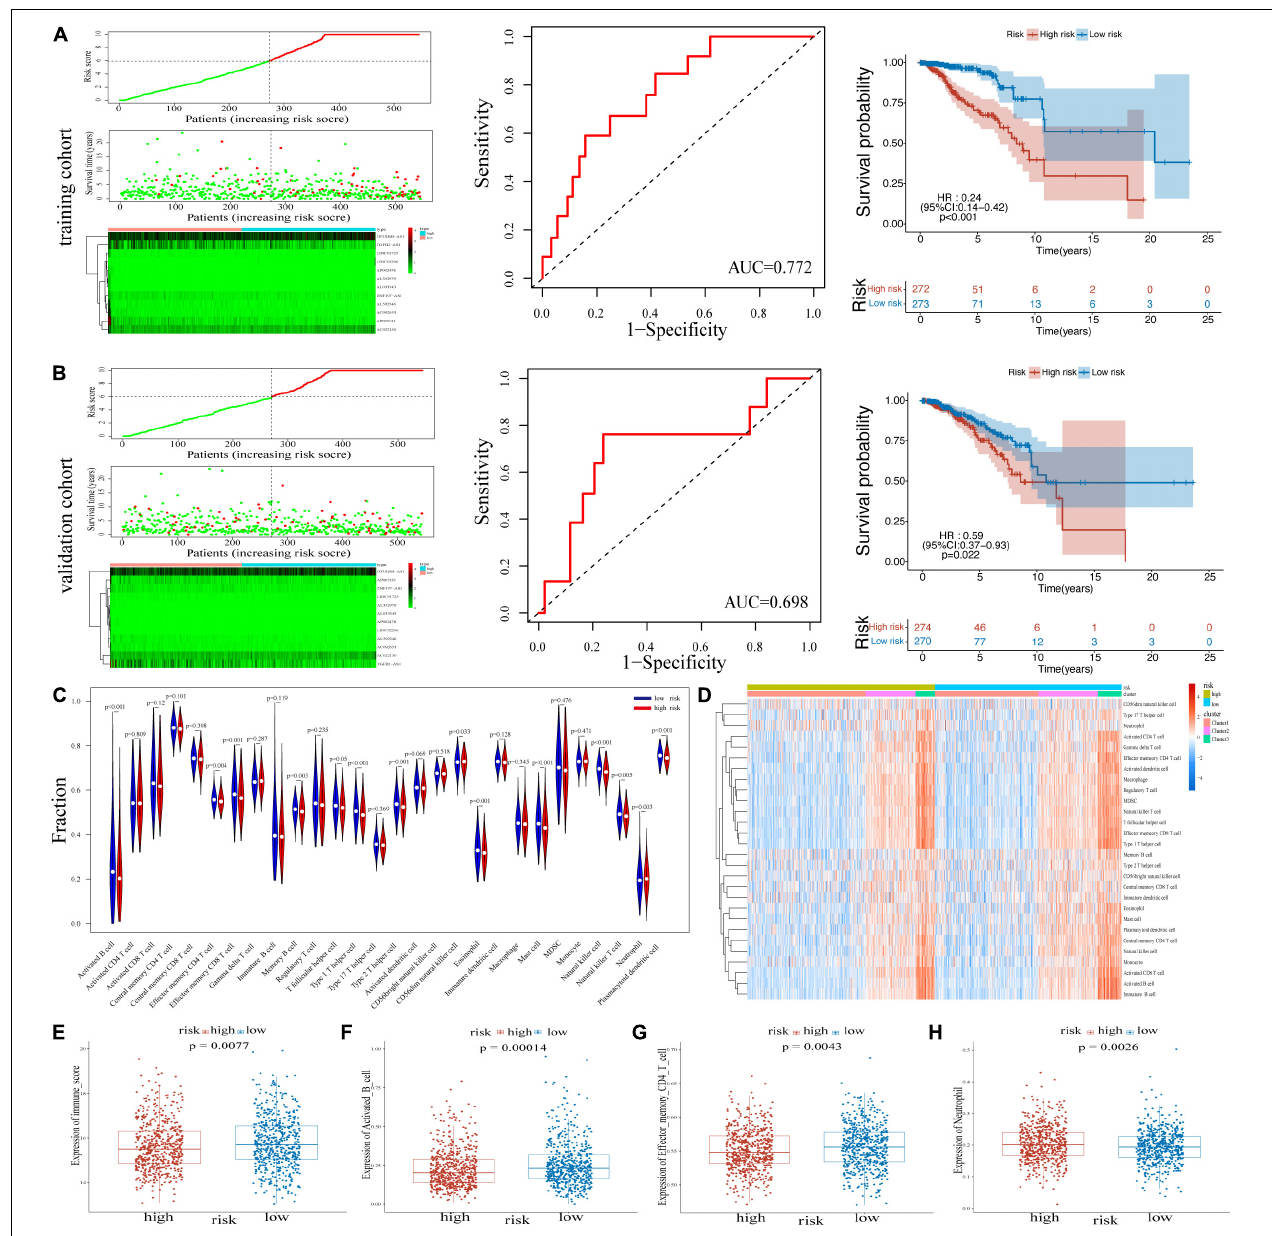
FIGURE 2 | Heatmap, distribution of risk scores, survival status, and Kaplan–Meier curves of OS for BRCA patients in TCGA training cohort (A) and validation cohort (B) . (C) The infiltrating levels of 22 immune cell types in high-/low-risk subtypes. * p < 0.05 and ** p < 0.01. (D) Heatmap of correlations between 22 immune cell types with risk scores and clusters. (E) Immune score in the high- and low-risk groups. (F–H) Activated B cell, effector memory CD4 T cell, and neutrophil in two risk groups. OS, overall survival; BRCA, breast cancer; TCGA, The Cancer Genome Atlas.